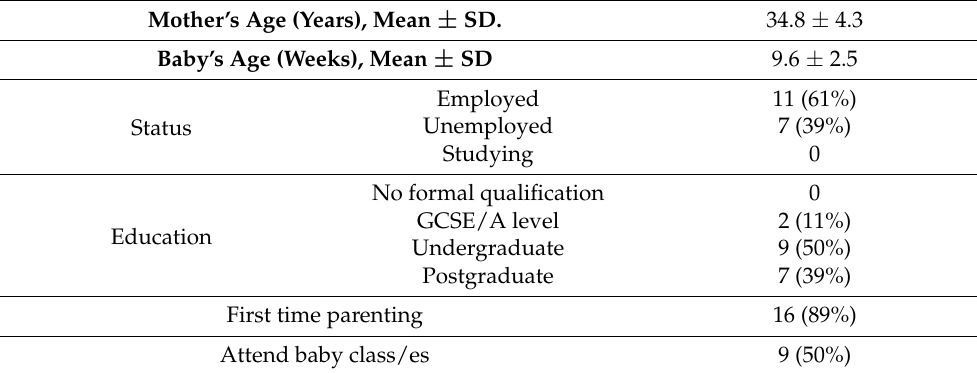
Table 1. Baseline